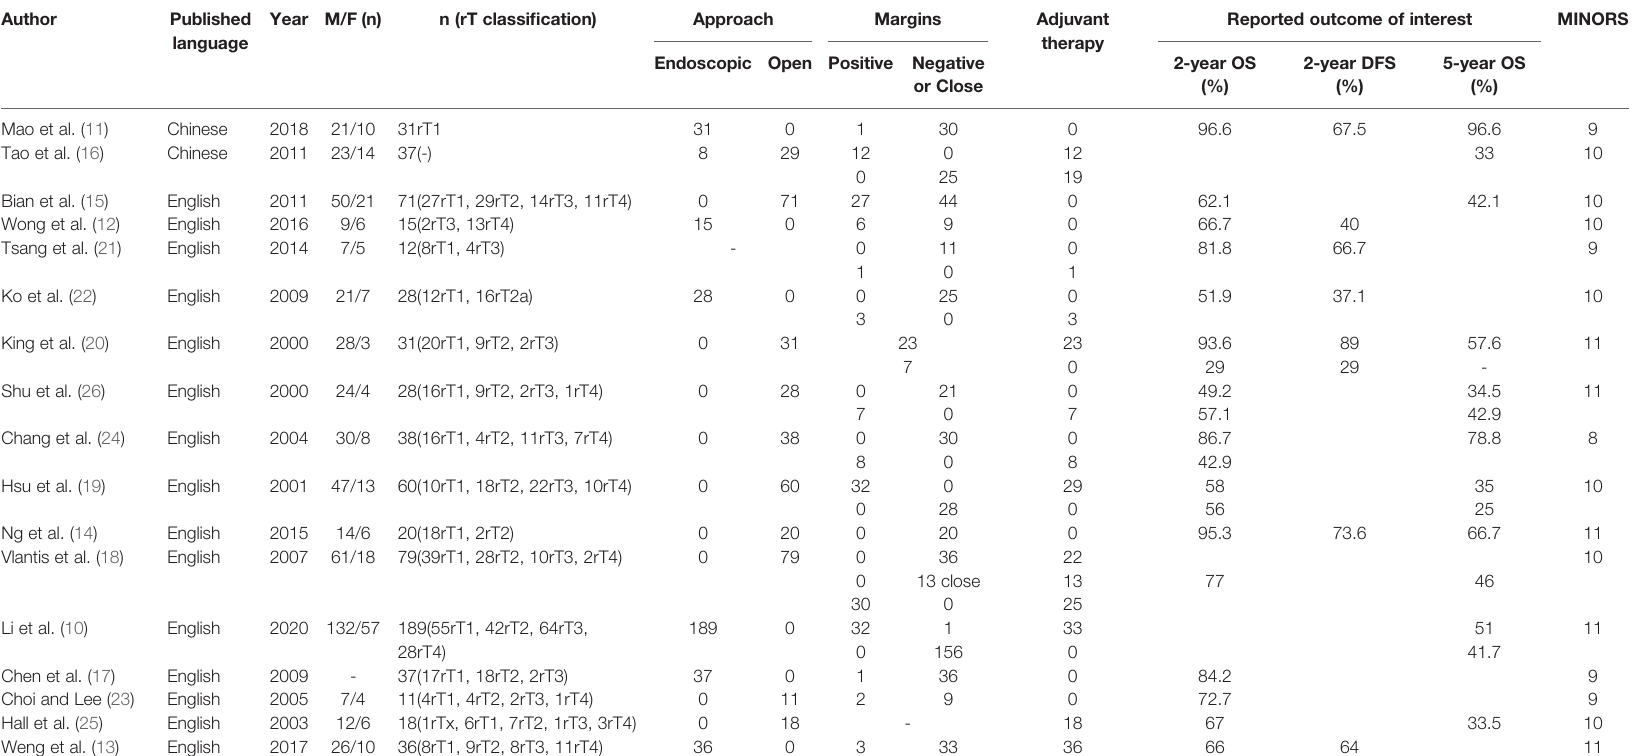
TABLE 1 | Main characteristics of the articles included in the meta-analysis.